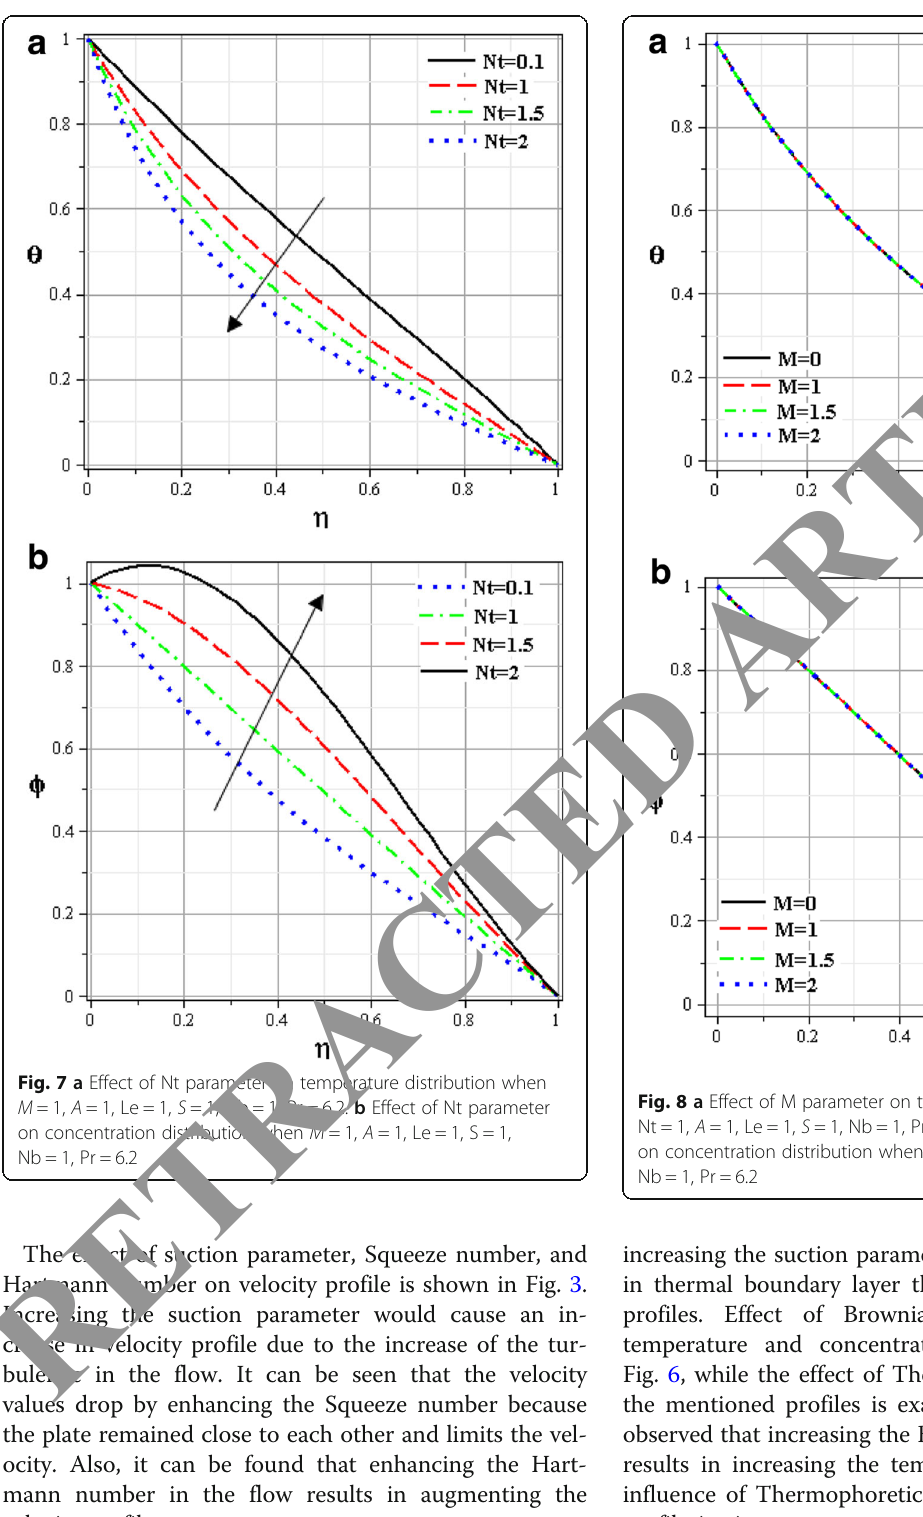
Fig. 8 a Effect of M parameter on temperature distribution when Nt = 1, A = 1, Le = 1, S = 1, Nb = 1, Pr = 6.2. b Effect of M parameter on concentration distribution when Nt = 1, A = 1, Le = 1, S = 1, Nb = 1, Pr =